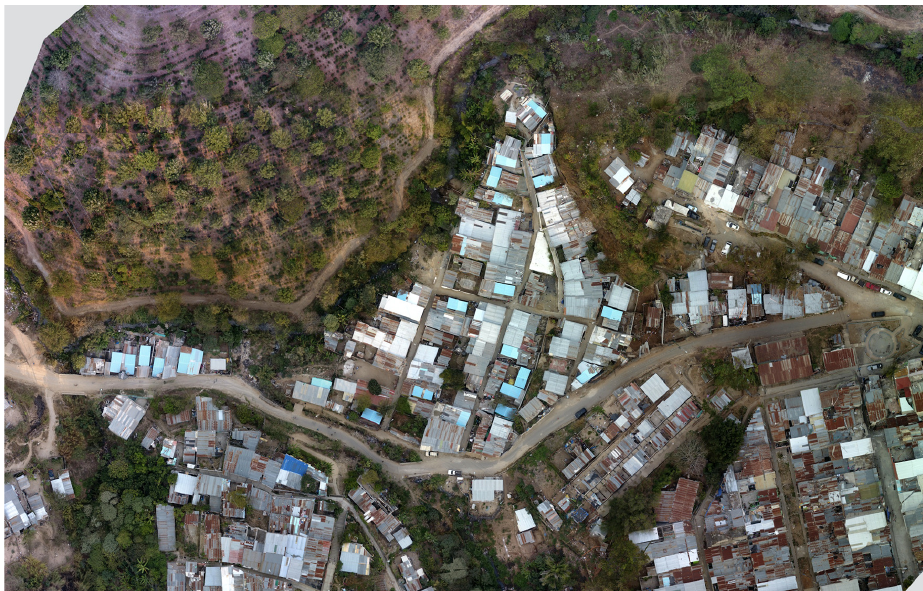
Figure 2. Orthophoto of 5 de Noviembre, courtesy of Perpendicular.